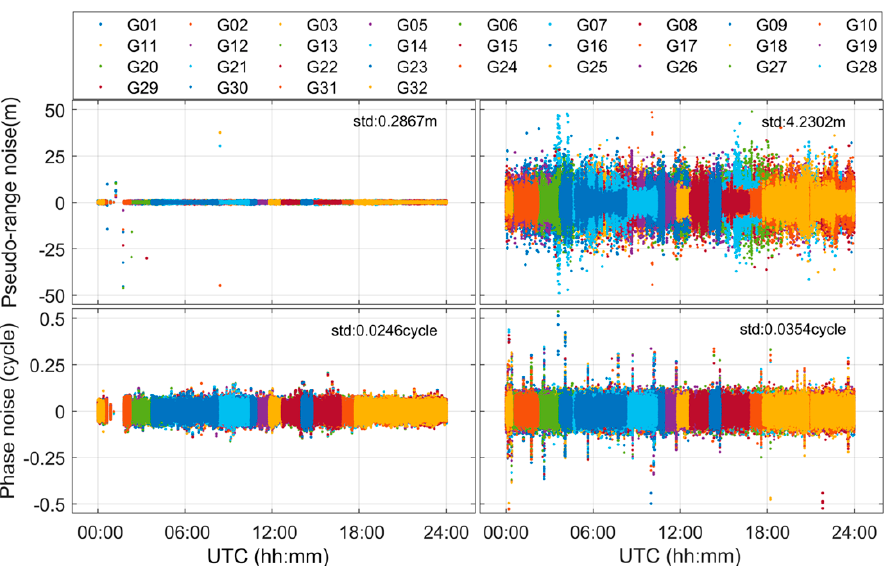
Figure 7. The pseudorange and carrier-phase measuring noise of GPS observations for NetR9 ( left panel ) and Nexus 9 ( right panel ) in a 1-day span.